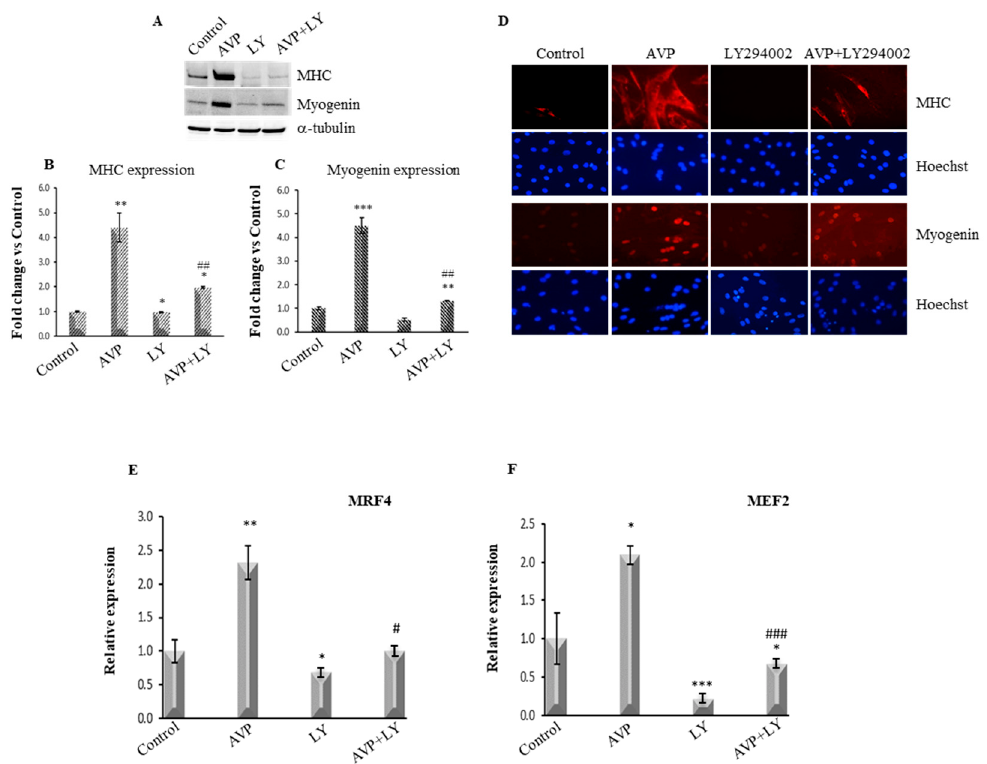
Figure 4. LY294002 down-regulates the AVP-dependent induction of MHC and myogenin expression. L6 cells were plated in growth medium and after 24 h were shifted in serum-free medium and treated with 0.1 µ M AVP in the presence and in the absence of 20 µ M LY294002. ( A ) Western Blot analysis of MHC and myogenin expression was performed after 48 h of culture. ( B , C ) Densitometric analyses were achieved using an α -tubulin antibody to verify equal loading of the samples. ( D ) Immunofluorescence analysis of L6 cells treated with the same condition described above was achieved to evaluate MHC and myogenin expression levels. (Magnification 20 × ). ( E , F ) Real-Time PCR analysis was carried out to evaluate the MRF4 (Myf6) and MEF2 mRNA expression levels. The experiments were performed three times, and representative results are shown. Statistical analysis was performed using Student’s t -test. * ,# p < 0.05; ** ,## p < 0.01; *** ,### p < 0.001. * vs. Control; # vs. LY294002.